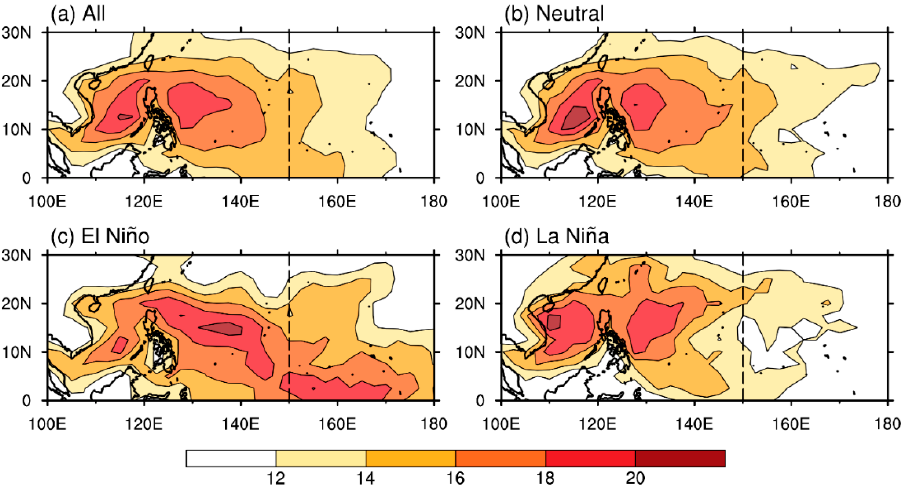
Figure 4. Composites of seasonal-mean Madden–Julian Oscillation (MJO) activity represented by the root mean square (RMS) value of filtered outgoing longwave radiation (OLR) anomalies (unit: W·m − 2 ) for ( a ) all years, ( b ) neutral years, ( c ) the El Niño years, and ( d ) the La Niña years during the TC season (June–November) over the period of 1979–2016.